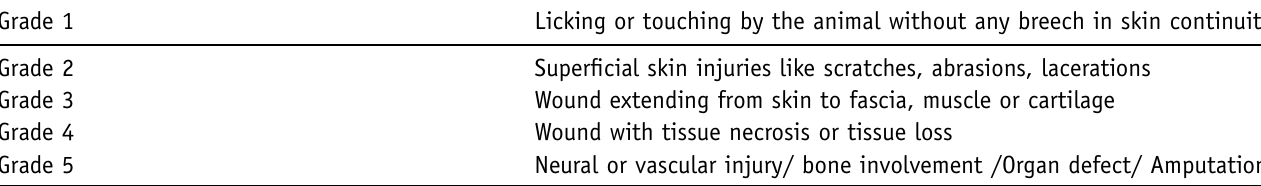
Table V. Proposed Singhal-Sikka Classi fi cation of Animal bite